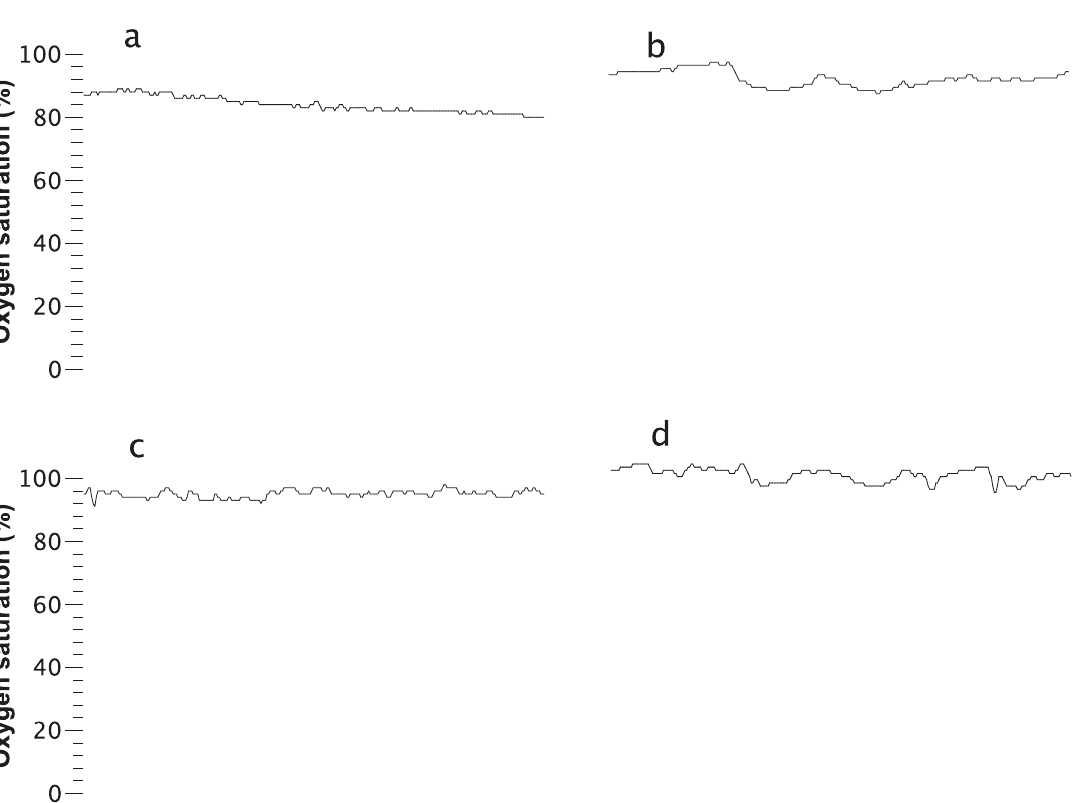
Fig. 5 Lower moving threshold in oxygen saturation predicts increased risk of death. Four 10 min heart rate records that correspond to increasing death risk with a decreasing percentile value for oxygen saturation moving threshold. The record in ( a ) was the 0.5 percentile value and re fl ected tenfold increased risk of death. b – d Show records with moving threshold percentiles 10, 50, and 75, and fold-increased risks of death 2.3, 0.6, and 0.4,